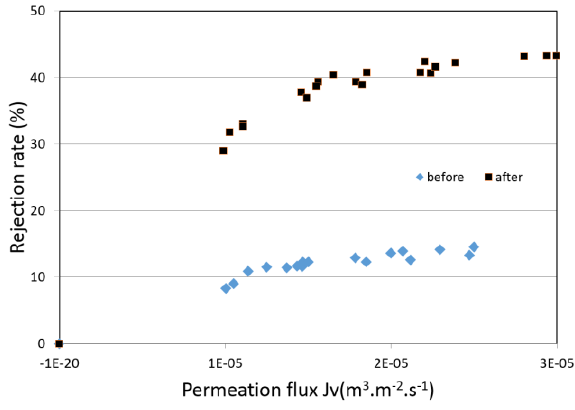
Figure 7. Rejection rates of NaCl-water solutions vs. permeation flux (membrane 1). Membranes 2017 , 7 , 65